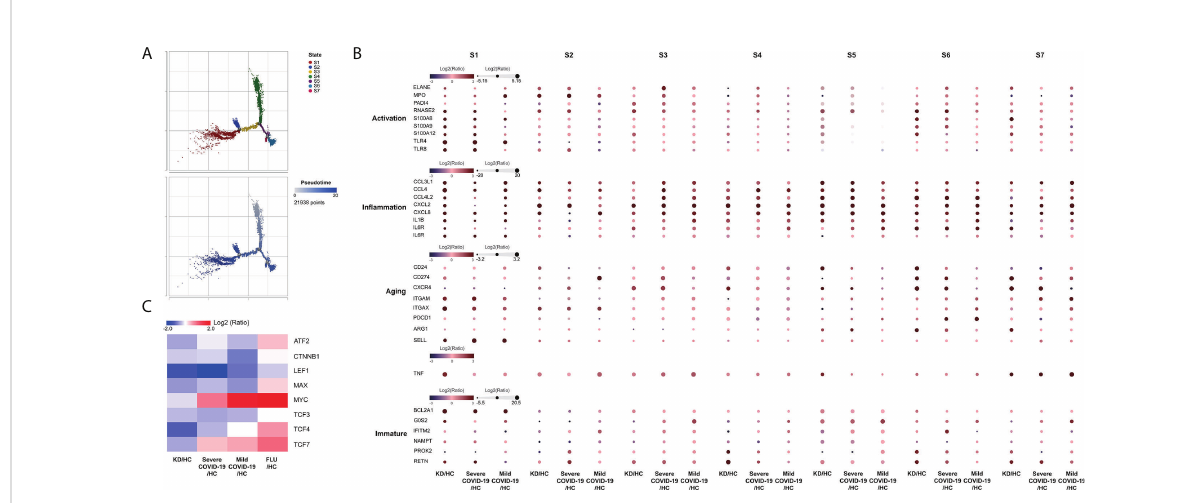
FIGURE 6 Monocle trajectory of neutrophils. (A) Trajectory analysis of neutrophils using Monocle 2 was colored by states (upper panel) and pseudotime maps (lower panel) showed changes in neutrophil differentiation. Cell states were inferred from the expression genes in neutrophils. (B) Activation-, in fl ammation-, aging- and immaturation-related genes in neutrophil subpopulations of different states. (C) Heatmap showing the signi fi cant differential expression of aging-related cell proliferation genes in